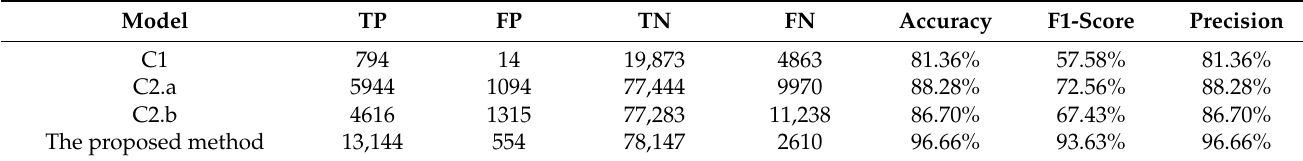
Table 5. The classifier result